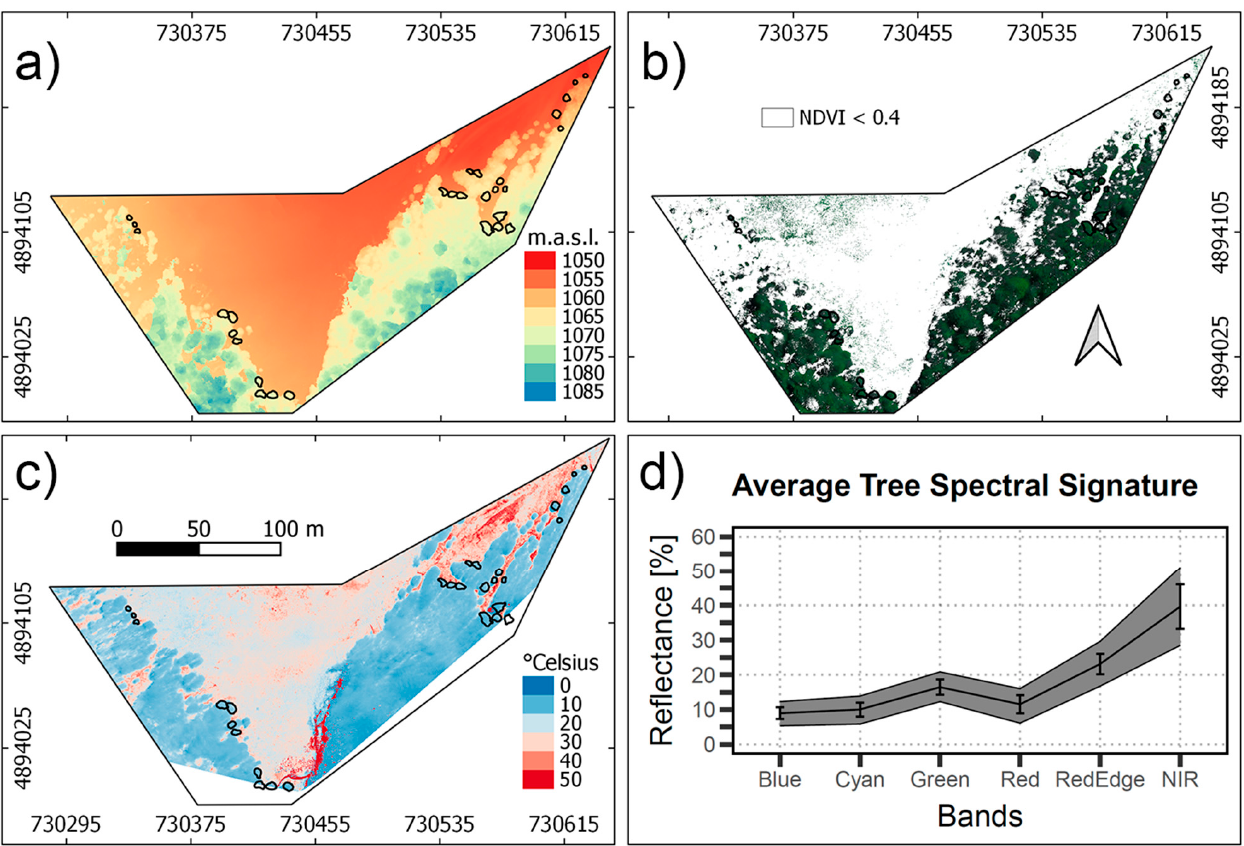
Figure 4. ( a ) Digital Surface Model of the study area used for the >2 m height criteria. ( b ) Multispectral image composite (R, G, B bands) masked with an NDVI < 0.4 criteria. ( c ) Temperature of the study area. ( d ) Vegetation spectra for the canopy pixels selected, the black line represents the average spectra, and for each band, the standard deviation is specified.